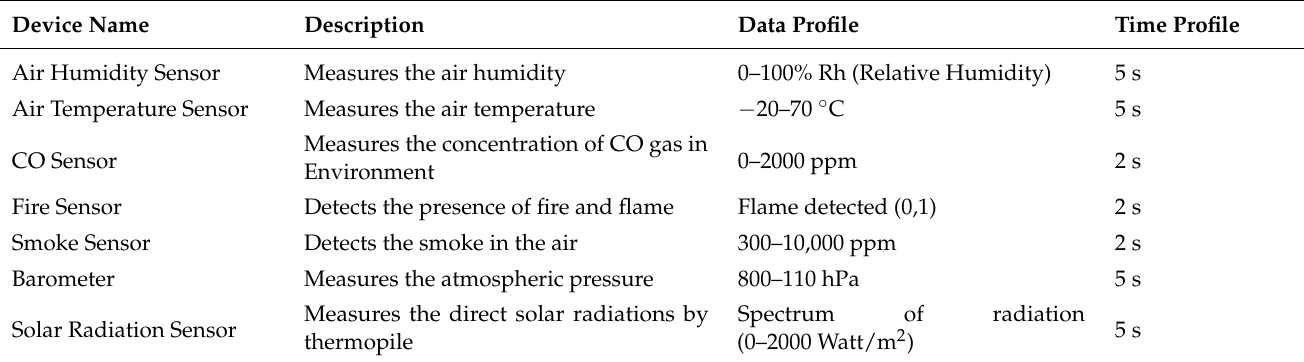
Table 1. Environment monitoring sensors.